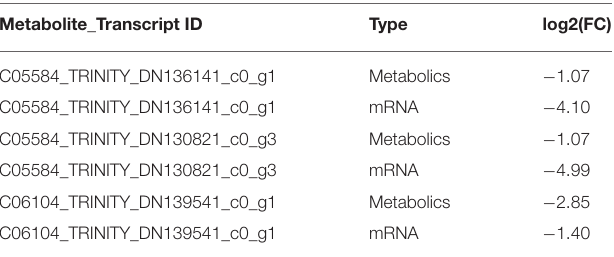
TABLE 6 | Results of differential co-expression of pituitary metabolites and related transcripts in Zi-geese. Metabolite_Transcript ID